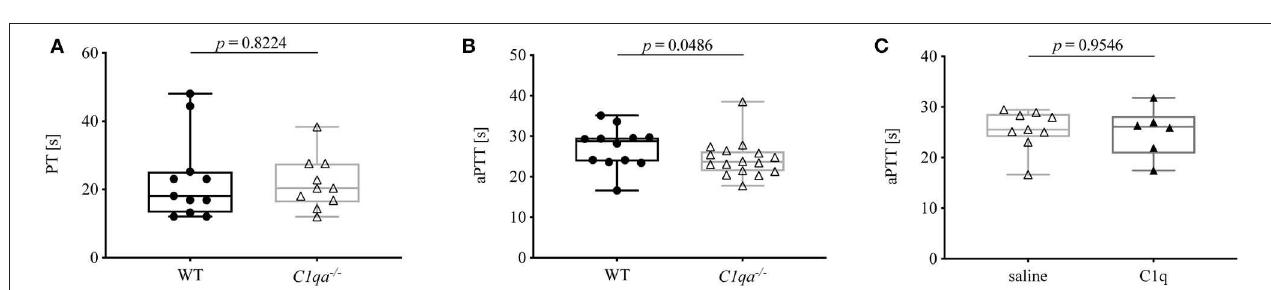
FIGURE 2 | Prothrombin time and activated partial thromboplastin time of C1q-deficient vs. WT mice. (A) Citrated whole blood of WT and C1q-deficient mice was analyzed for prothrombin time. (B,C) Citrated blood plasma of (B) WT and C1q-deficient mice and of (C) saline injected and C1q injected C1q-deficient mice was analyzed for activated partial thromboplastin time. Horizontal lines in the box plots denote median while the boxes indicate interquartile range and whiskers minimum and maximum values. Data points represent individual mice, (A) n = 10 for each group; (B) : n = 12, △ : n = 16; (C) △ : n = 9, N : n = 6 (Mann–Whitney test).